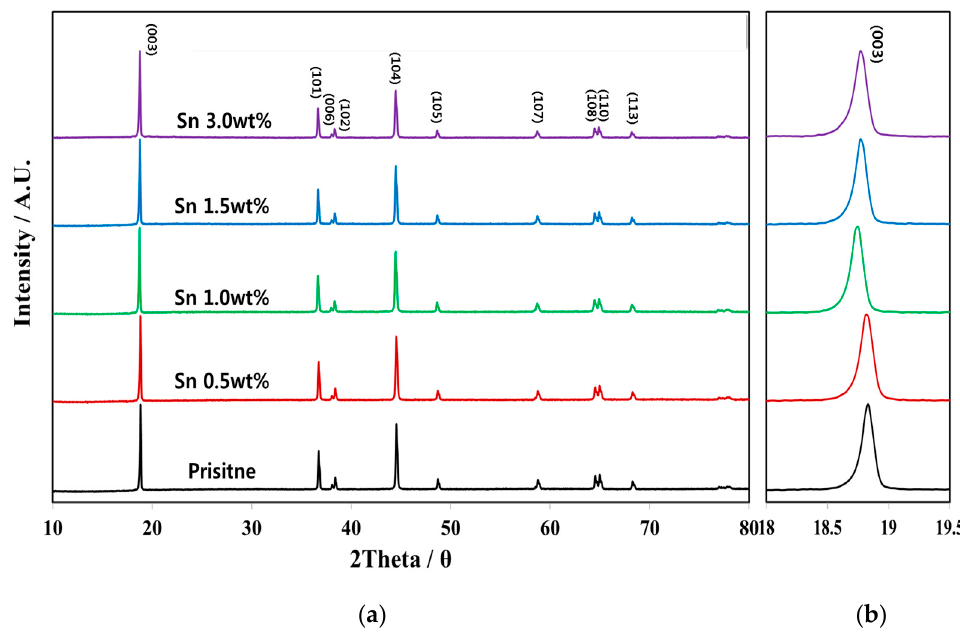
Figure 3. XRD patterns of the cathode active materials: ( a ) full spectrum and ( b ) expanded view around (003). Table 1. Lattice parameters of the cathode active materials.